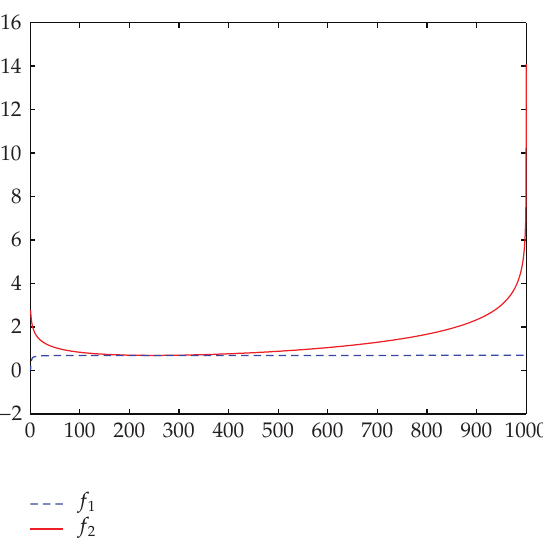
Figure 1: The bound of bipartite toughness in Theorems 1.2 and 1.3, illustrated with n (cid:7) 1000. The x -axis is k and y -axis is log (cid:2) t B (cid:2) G (cid:3)(cid:3) . The bound is given by f 1 on the left and f 2 on the right of k (cid:7) (cid:2) n (cid:8) 4 (cid:3) /